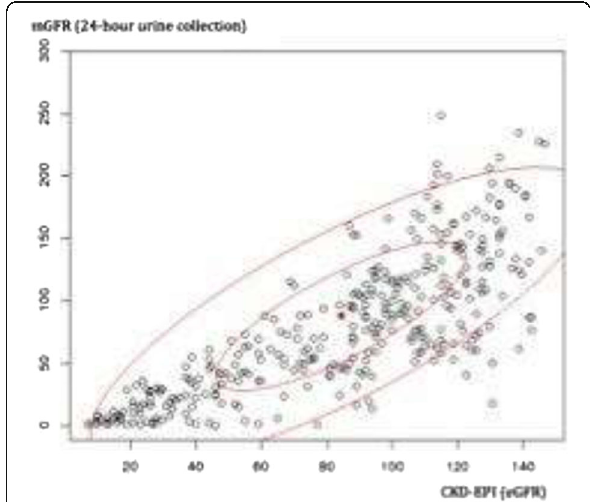
Fig. 2 (abstract 0153). mGFR and eGFR correlation (r= 0.78) in all